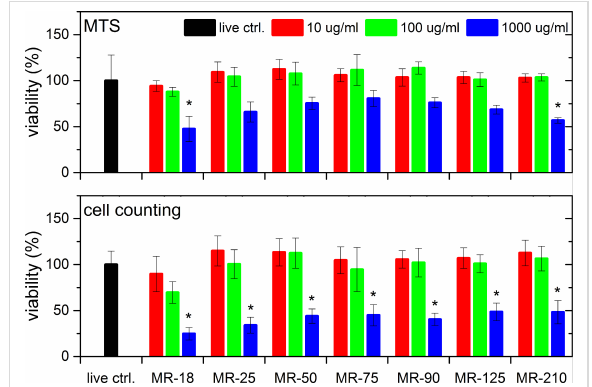
Figure 2: Viability of SAOS-2 cells incubated with HPHT NDs at three concentrations as a function of the mean particle diameter after 7 days. (Upper row) results of the MTS assay; (lower row) results of cell counting after cell staining. The results are given as the mean ± SD from 3 experiments, each performed in sextuplicate. ANOVA, Tukey HSD post-hoc test. “*” indicates a significant differ- ence from MR-18 at a concentration of 1000 µg/mL ( p < 0.05).